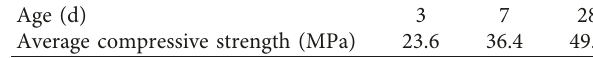
Table 2: Cubic compressive strength with different ages of the benchmark ordinary concrete.